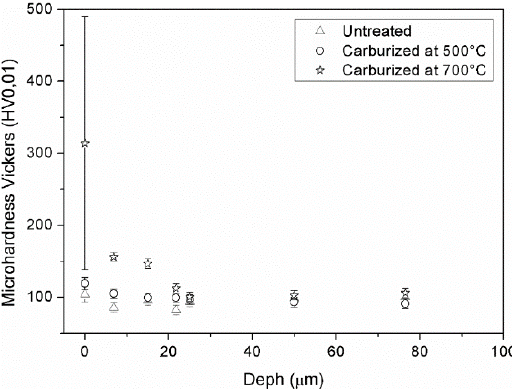
Figure 11. Microhardness profile of the layers carburized at 500 °C and 700 °C for 3 hours with 5% CH